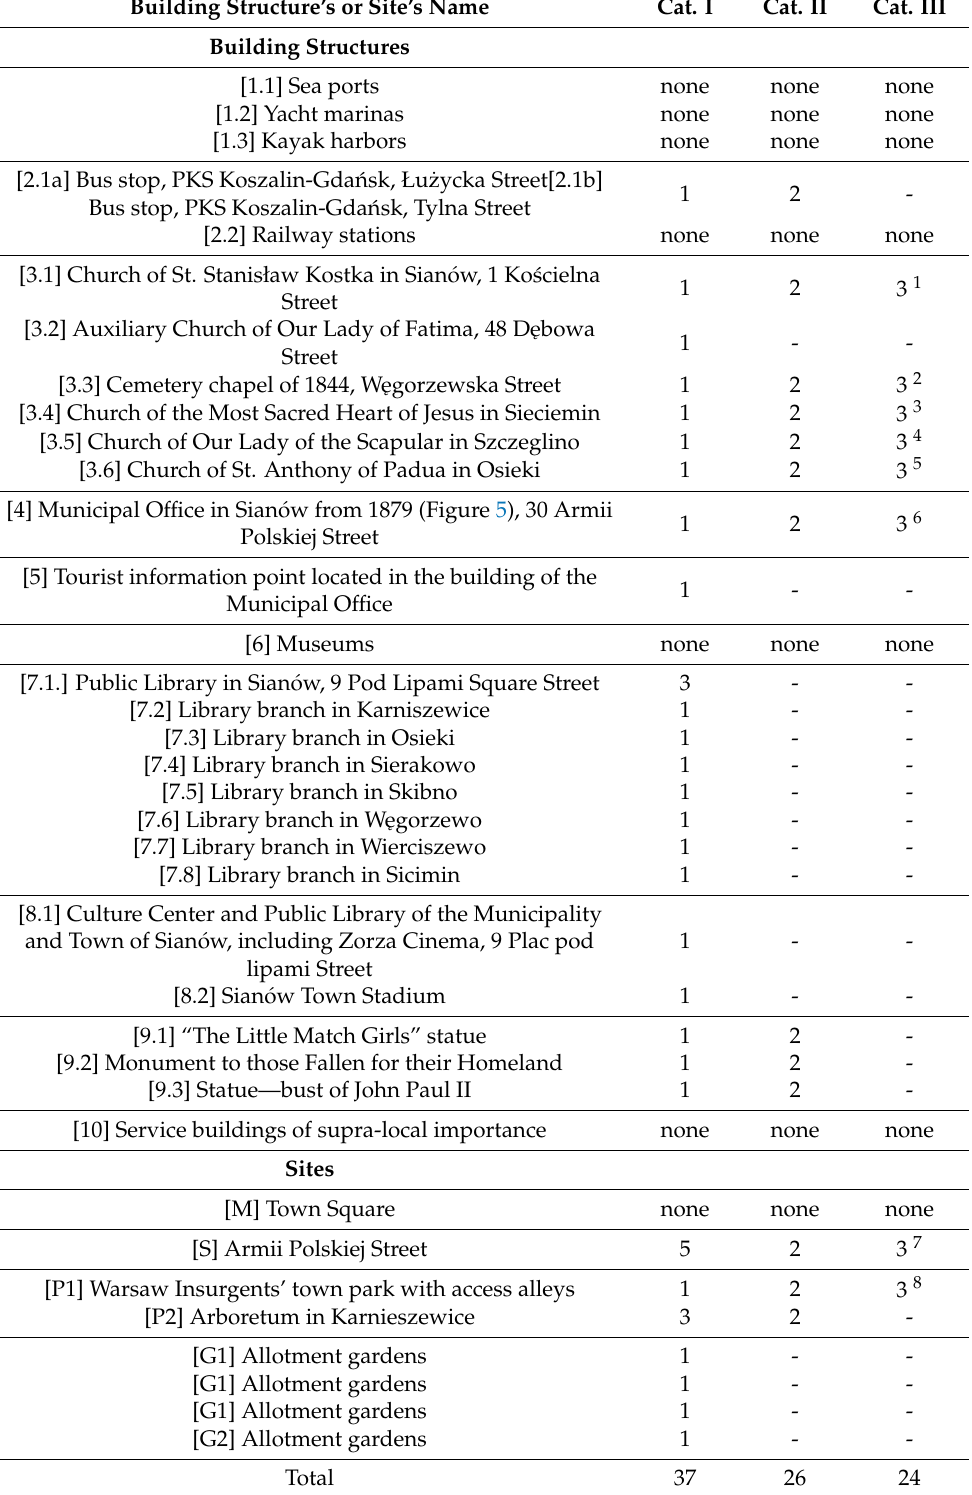
Table 8. The list of iconic building structures and sites with their assigned scores in Sian ó